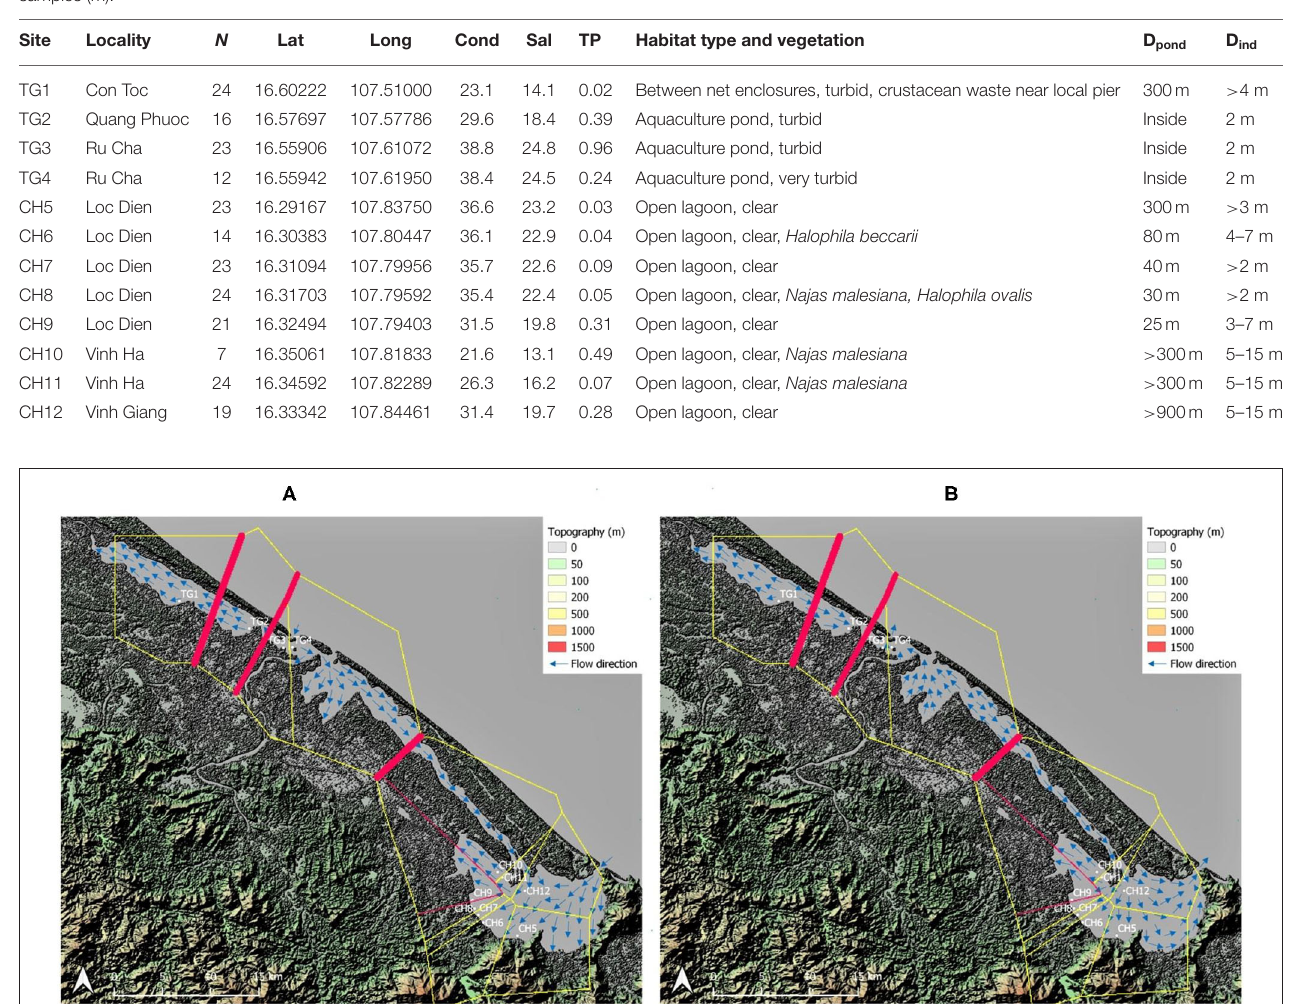
FIGURE 2 | Barrier analysis with thickest red lines indicating strongest differentiation between neighboring sampled sites. Topographic map of the sampling area including water flow direction adapted from Tran (2005) within the Tam Giang (TG)-Cau Hai (CH) lagoon system. (A) Flow direction during high tide in dry season; (B) Flow direction during low tide in dry season and during the rainy season. Map generated using the Quantum Geographical Information System, version 3.10.3 (QGIS).